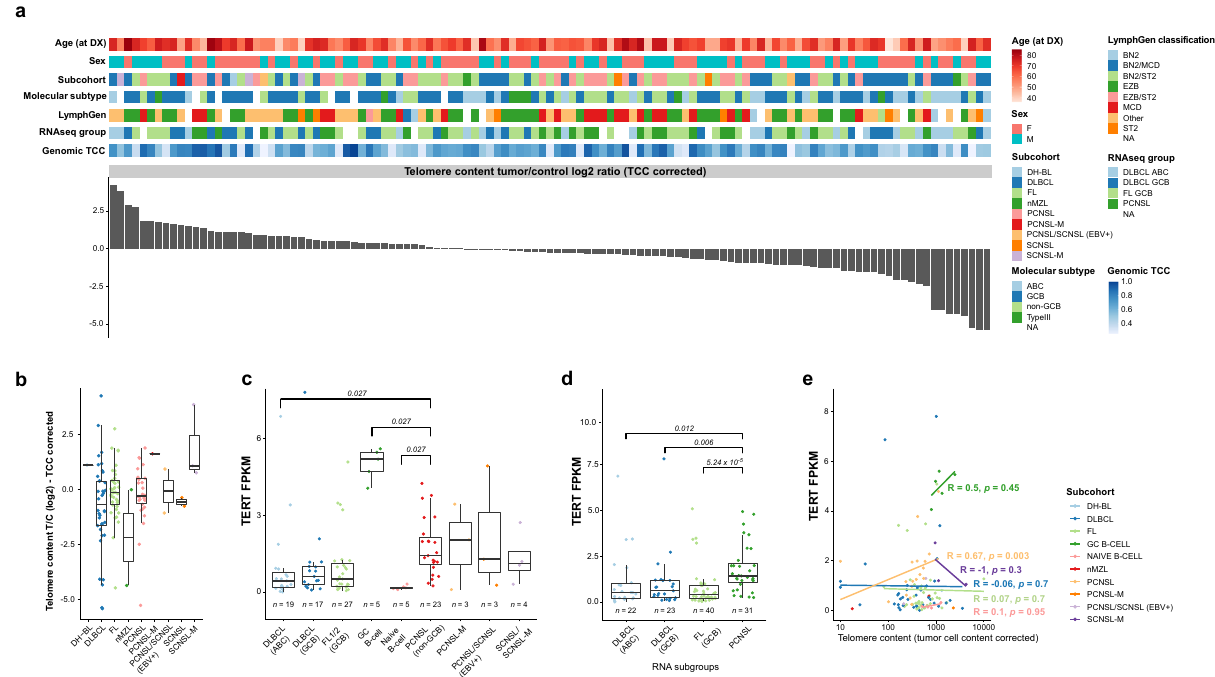
Fig. 8 TERT expression correlates with telomere content in PCNSL. Telomere content in DLBCL, FL, PCNSL, and SCNSL was estimated from WGS data using TelomereHunter. In about 1/3 of the samples, the telomere content was higher in the tumor than in the control sample ( a ). There was no statistical difference between PCNSL and other subcohorts in telomere content ( b ). TERT expression was signi fi cantly higher in PCNSL compared to subcohort ABC- DLBCL ( c ) and compared to RNA subgroups ABC-DLBCL, GCB-DLBCL, and FL ( d ). P -values in panels c and d are calculated using the one-sided Wilcox test adjusted for multiple testing using the Holm-Bonferroni method. Box and whisker plots show median (center line), the upper and lower quartiles (the box), and the range of the data (the whiskers), excluding outliers. A signi fi cant positive correlation between TERT expression and telomere content was only observed in PCNSL ( e ), using the Pearson correlation-coef fi cient test without correction for multiple